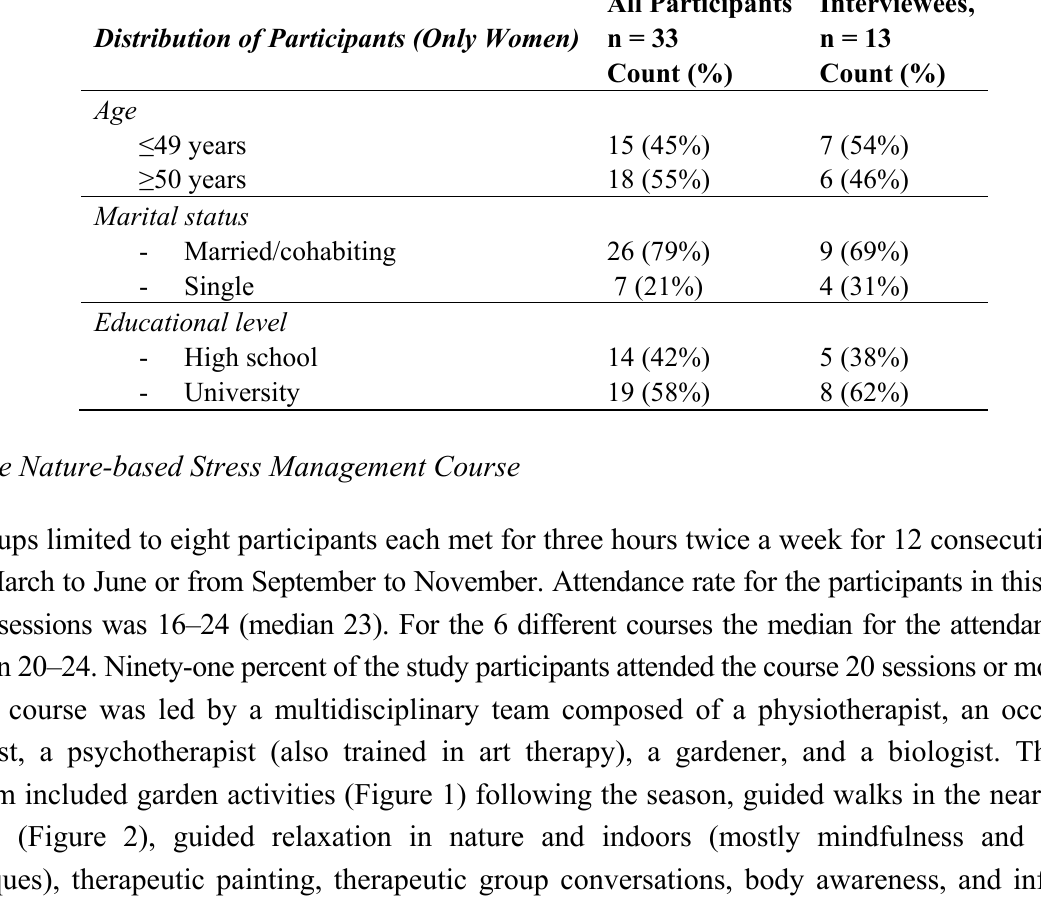
Table 1. Characteristics (count and percentage) of all participants and interviewees. Distribution of Participants (Only